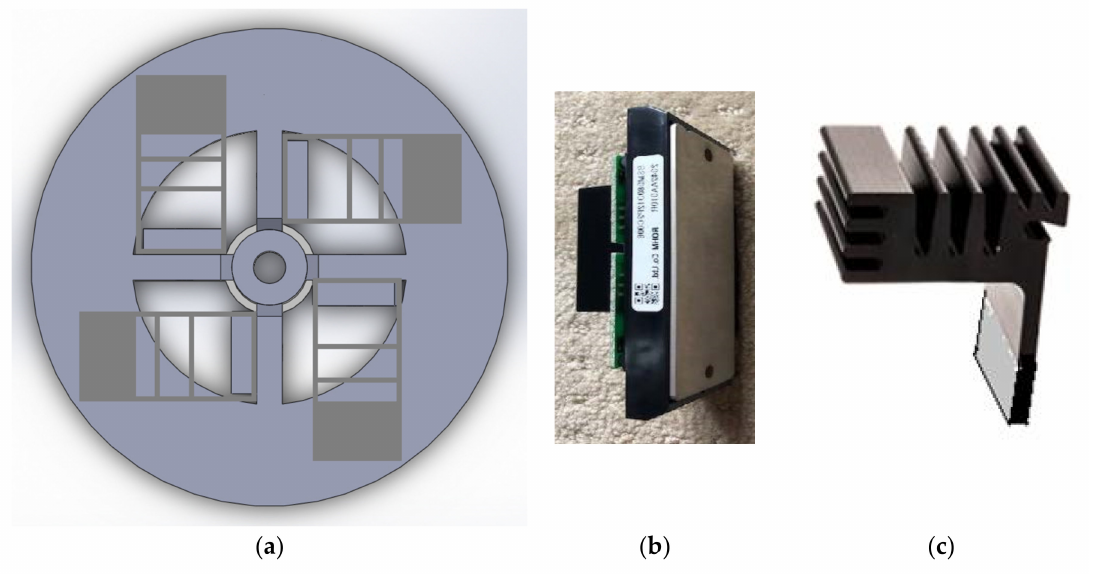
Figure 11. Cooling scheme of the integrated SiC devices and HF transformer.